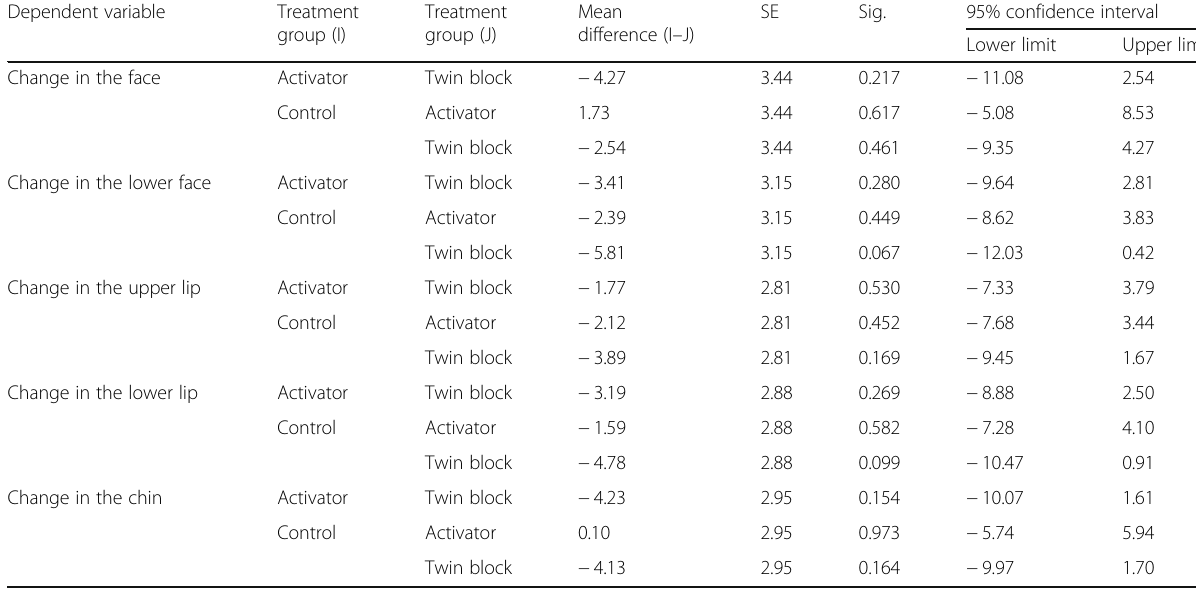
Table 5 Post hoc pairwise comparisons between treatment groups performed through Fisher ’ s least significant difference (LSD) test Dependent